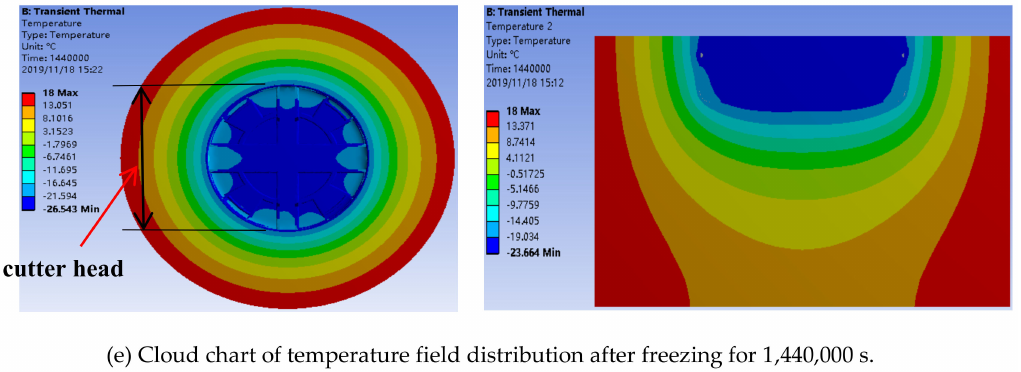
Figure 4. Temperature field contours of the frozen soil around the cutter head.